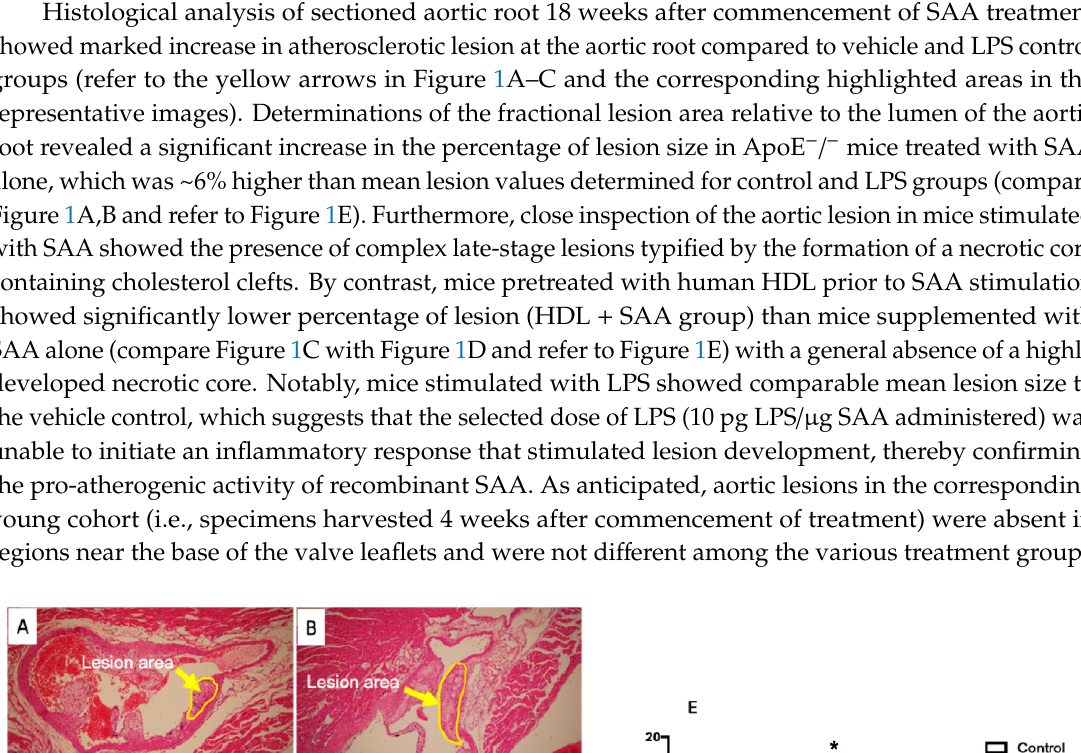
Figure 1. Pretreatment with HDL inhibits SAA ‐ induced aortic lesion in ApoE − / − mice. Male ApoE − / − mice were randomly allocated into 4 treatment arms and administered with vehicle (control), LPS, SAA alone, or SAA in combination with HDL as described in the methods section. Mice were monitored for 18 weeks after commencement of treatment then sacrificed, and hearts and aortae were harvested. The extent of vascular lesion was expressed as the relative percentage of lesion size (determined as lesion area/corresponding luminal area at the aortic root calculated using Image J software (v1.42, NIH, USA). Representative sections show control ( A ) control, ( B ) LPS, ( C ) SAA ‐ treated, and ( D ) isolated human HDL preloaded to animals prior to SAA treatment. Yellow arrows identify atherosclerotic lesions developing in the aortic root. ( E ) The percentage of lesion area normalized to the total area was analyzed across all treatment groups with mice numbers control ( n = 6), LPS ( n = 6), SAA ( n = 6), and HDL/SAA ( n = 6). * Different to the vehicle and LPS control groups, p < 0.001. # Different to the lesion measured in mice receiving SAA alone, p < 0.05.